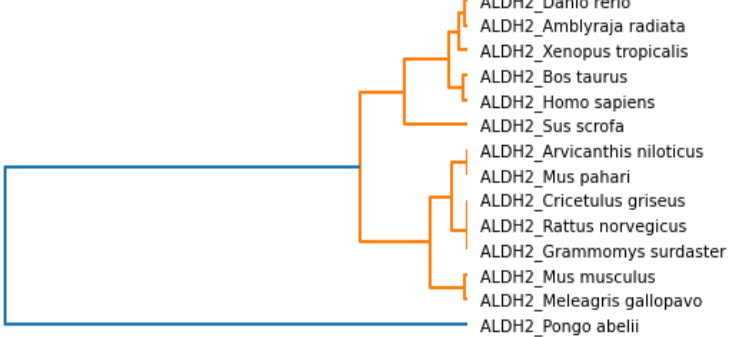
Figure 11. Hierarchical clustering phylogenetic tree based on Hurst exponent.